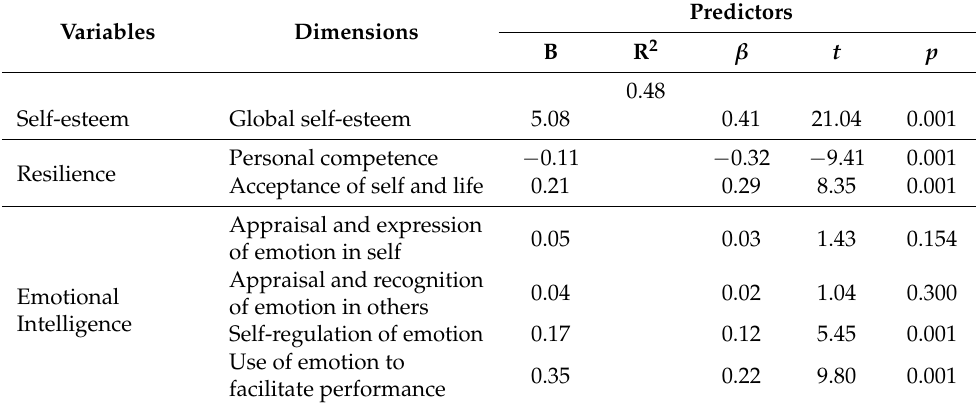
Table 4. Simultaneous multiple regression analysis to predict satisfaction with